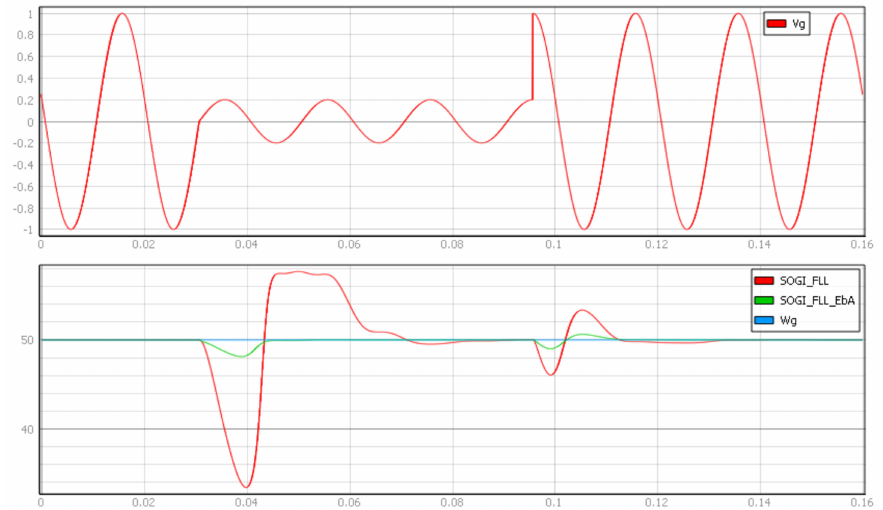
Figure 12. HIL results for the SOGI-FLL and SOGI-FLL-EbA to short-duration voltage sag. ( up ) Grid voltage sag fault going from 1 pu to 0.2 pu and going back to 1 pu. ( down ) SOGI-FLL (red) and SOGI-FLL-EbA (green) estimated frequency response to the voltage sag in Hz.